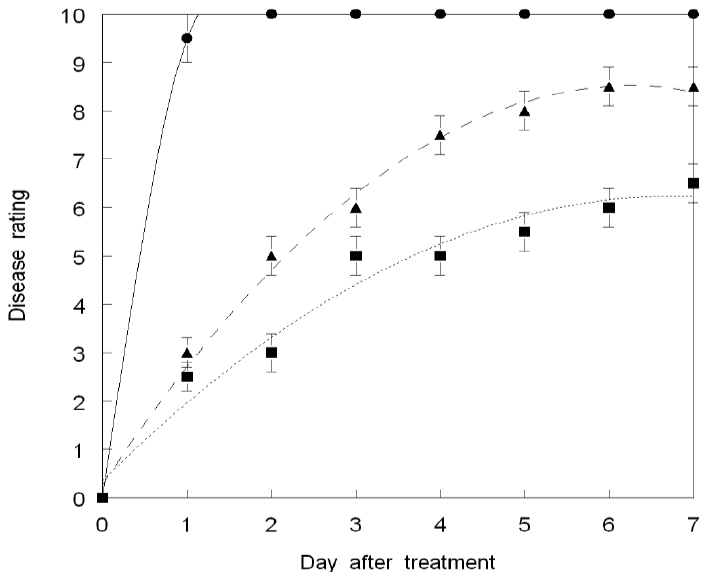
Figure 2. Disease progression of 10–20 cm tall hemp sesbania incited by Myrothecium verrucaria mycelia on hemp sesbania in the greenhouse. Disease severity was based on a visual rating scale (per plant basis) [50] to estimate disease progression. A rating scale of 0 to 10 was used, as described in the Materials and Methods section. Symptomatology was considered ―severe‖ at ratings of 8–10. The relationships for M. verrucaria disease progression are best described by the equations: Y = 2.67 + 3.76 X − 0.41 X 2 , R 2 = 0.72 (solid spheres, solid line) for M. verrucaria applied at an inoculum rate of 1.0×; Y = 0.36 + 2.17 − 0.15 X 2 , R 2 = 0.98 (solid triangles, dashed line) for M. verrucaria applied at an inoculum rate of 0.5×; Y = 0.65 + 1.07 − 0.03 X 2 , R 2 = 0.92 (solid squares, dotted line) for M. verrucaria applied at an inoculum rate of 0.1×. Error bars = ±1